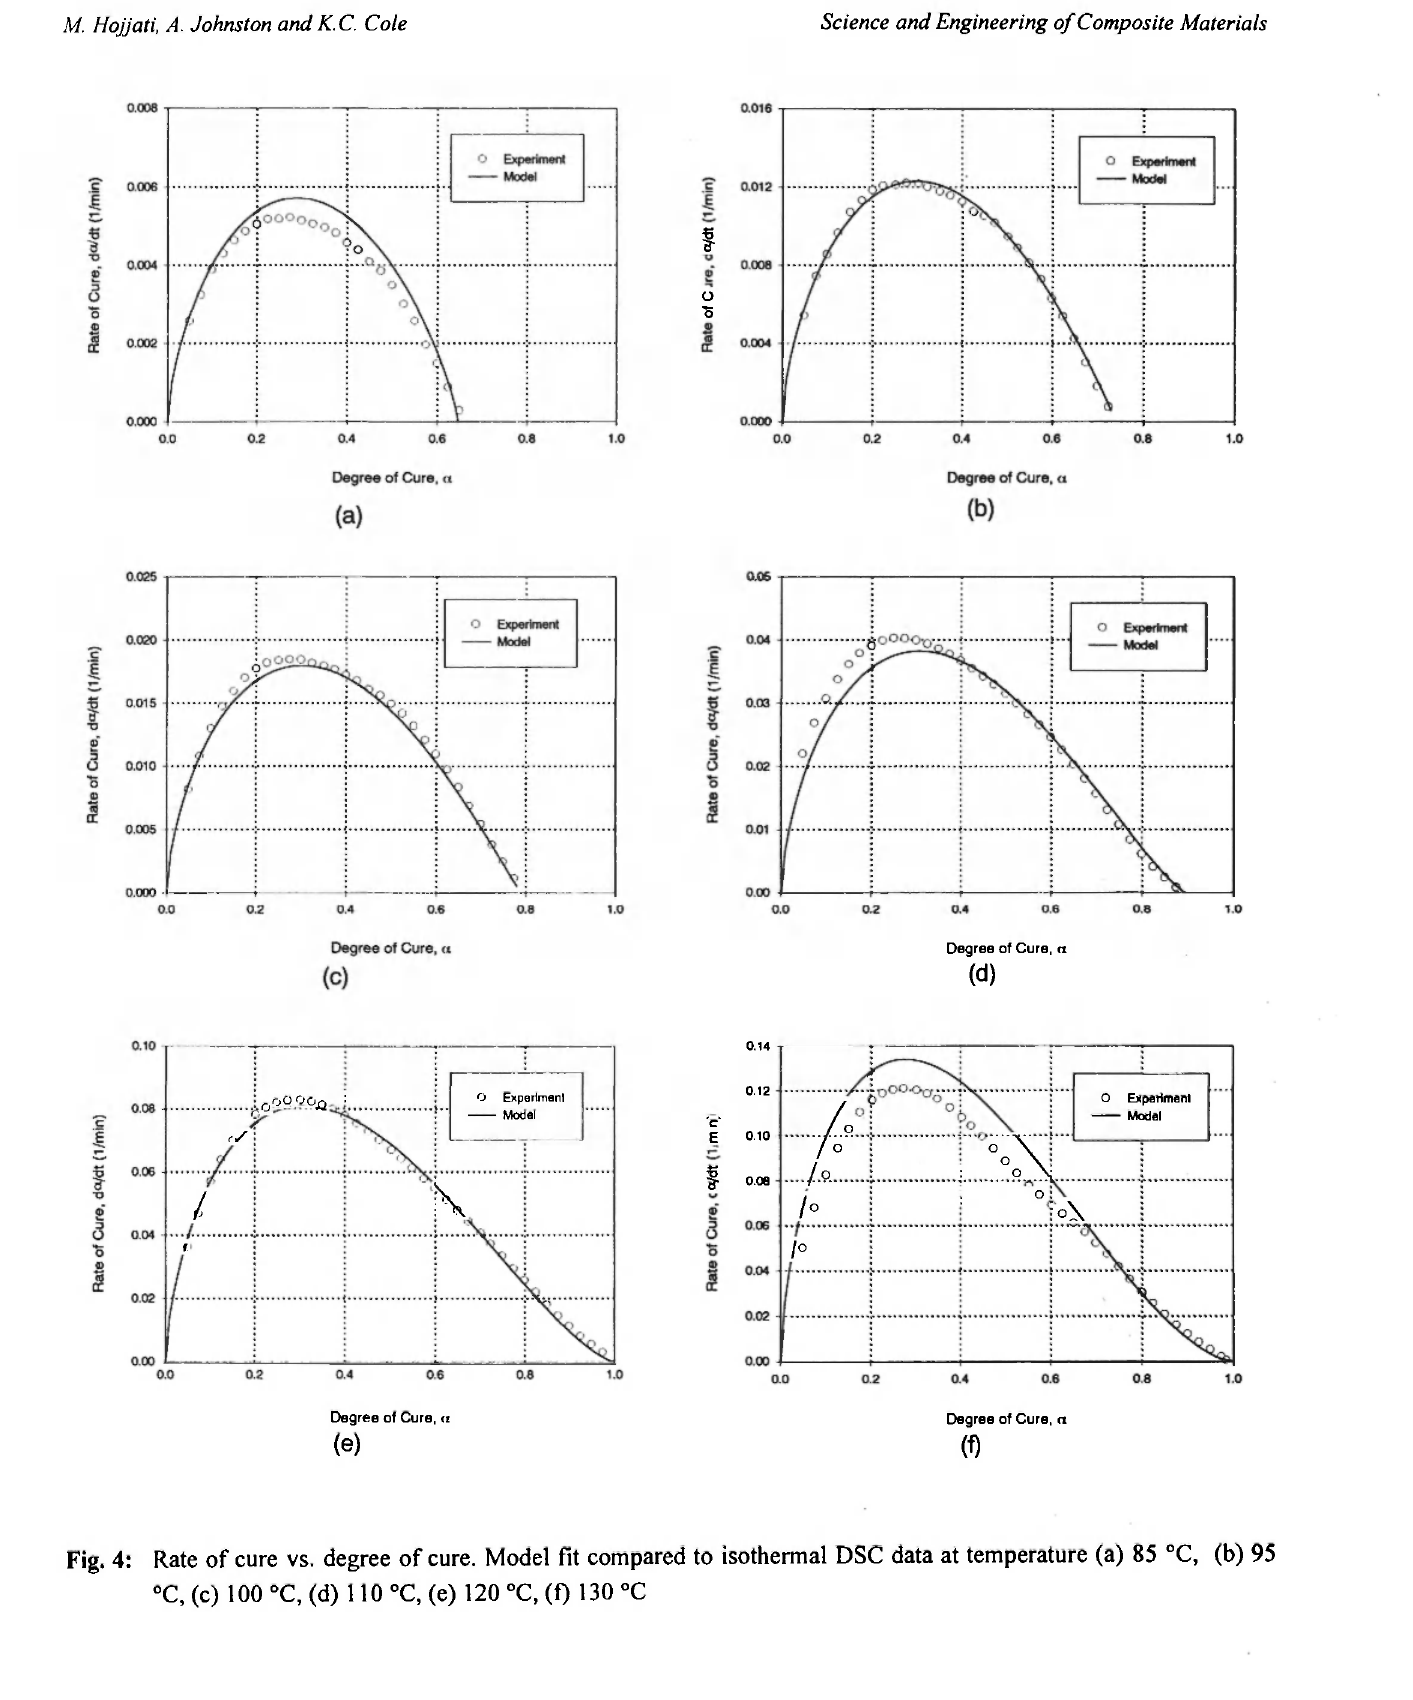
Fig. 4: Rate of cure vs. degree of cure. Model fit compared to isothermal DSC data at temperature (a) 85 °C, (b)